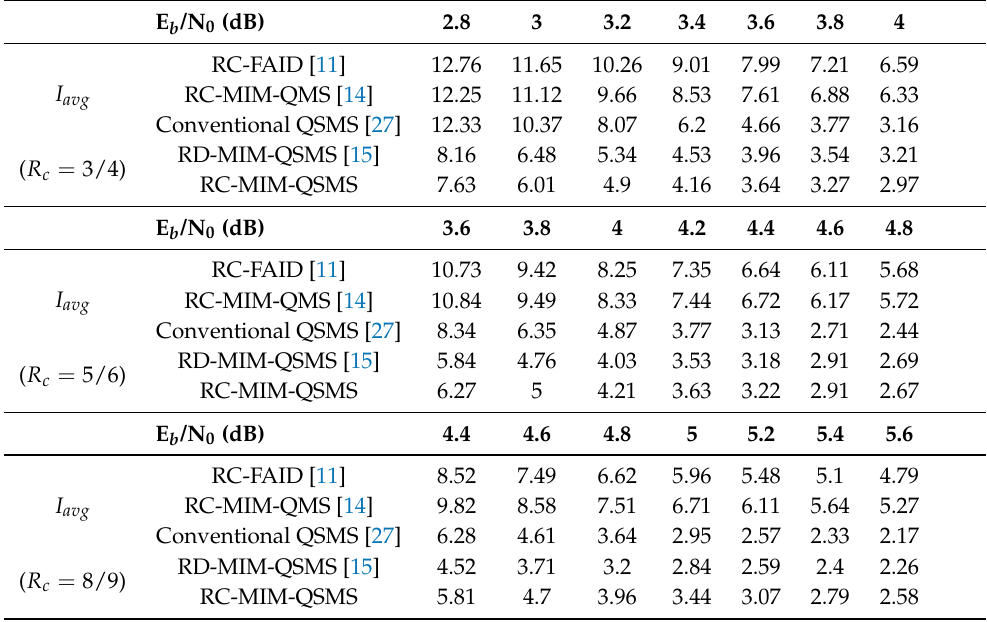
Table 4. The average number of iterations I avg of different LDPC decoders with q m = 4 for the 5G LDPC